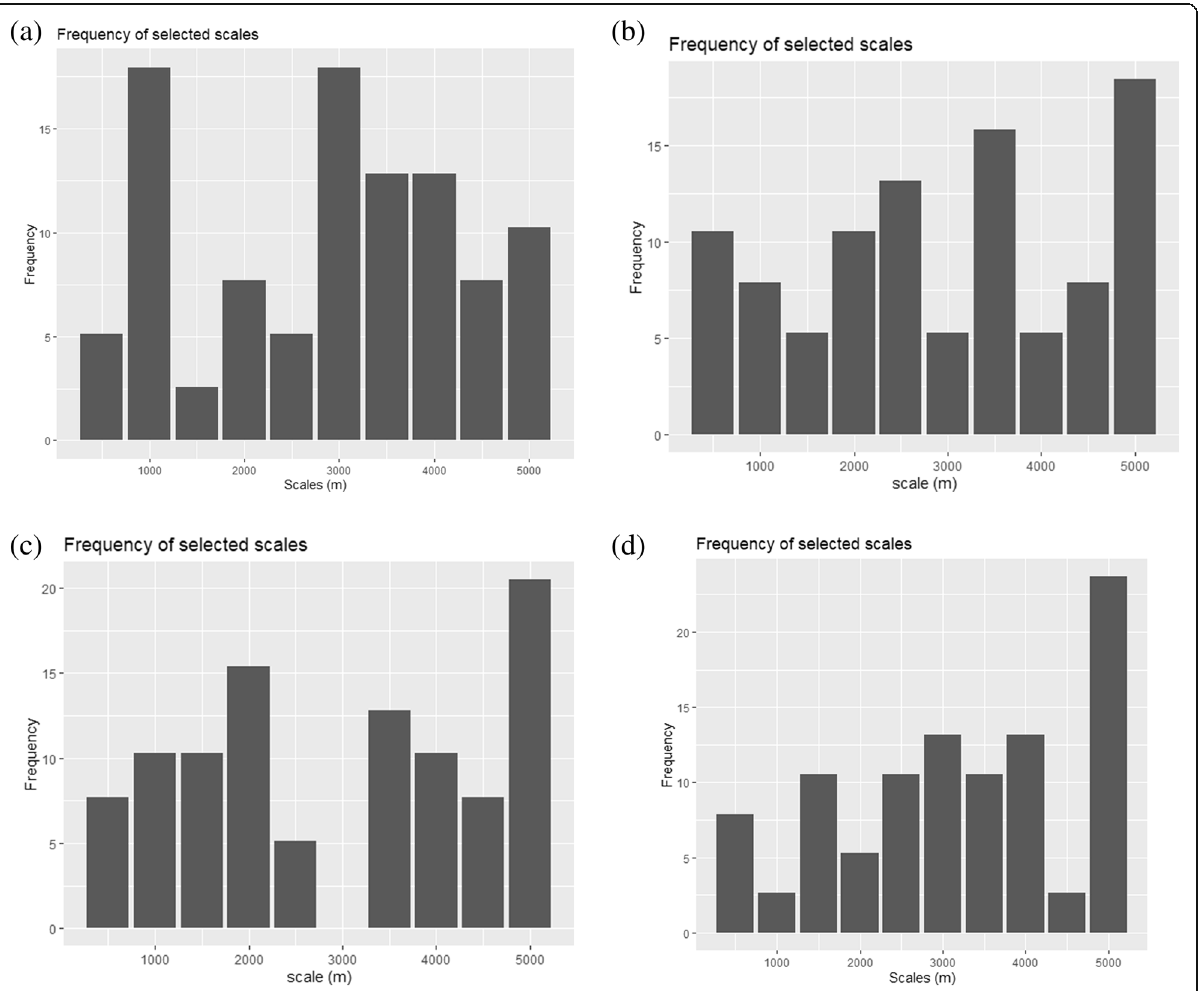
Fig. 3 Frequency of selected scales (in m) across all variables for the random forests model of a golden jackal, b jungle cat, c Asiatic wildcat, and d Indian